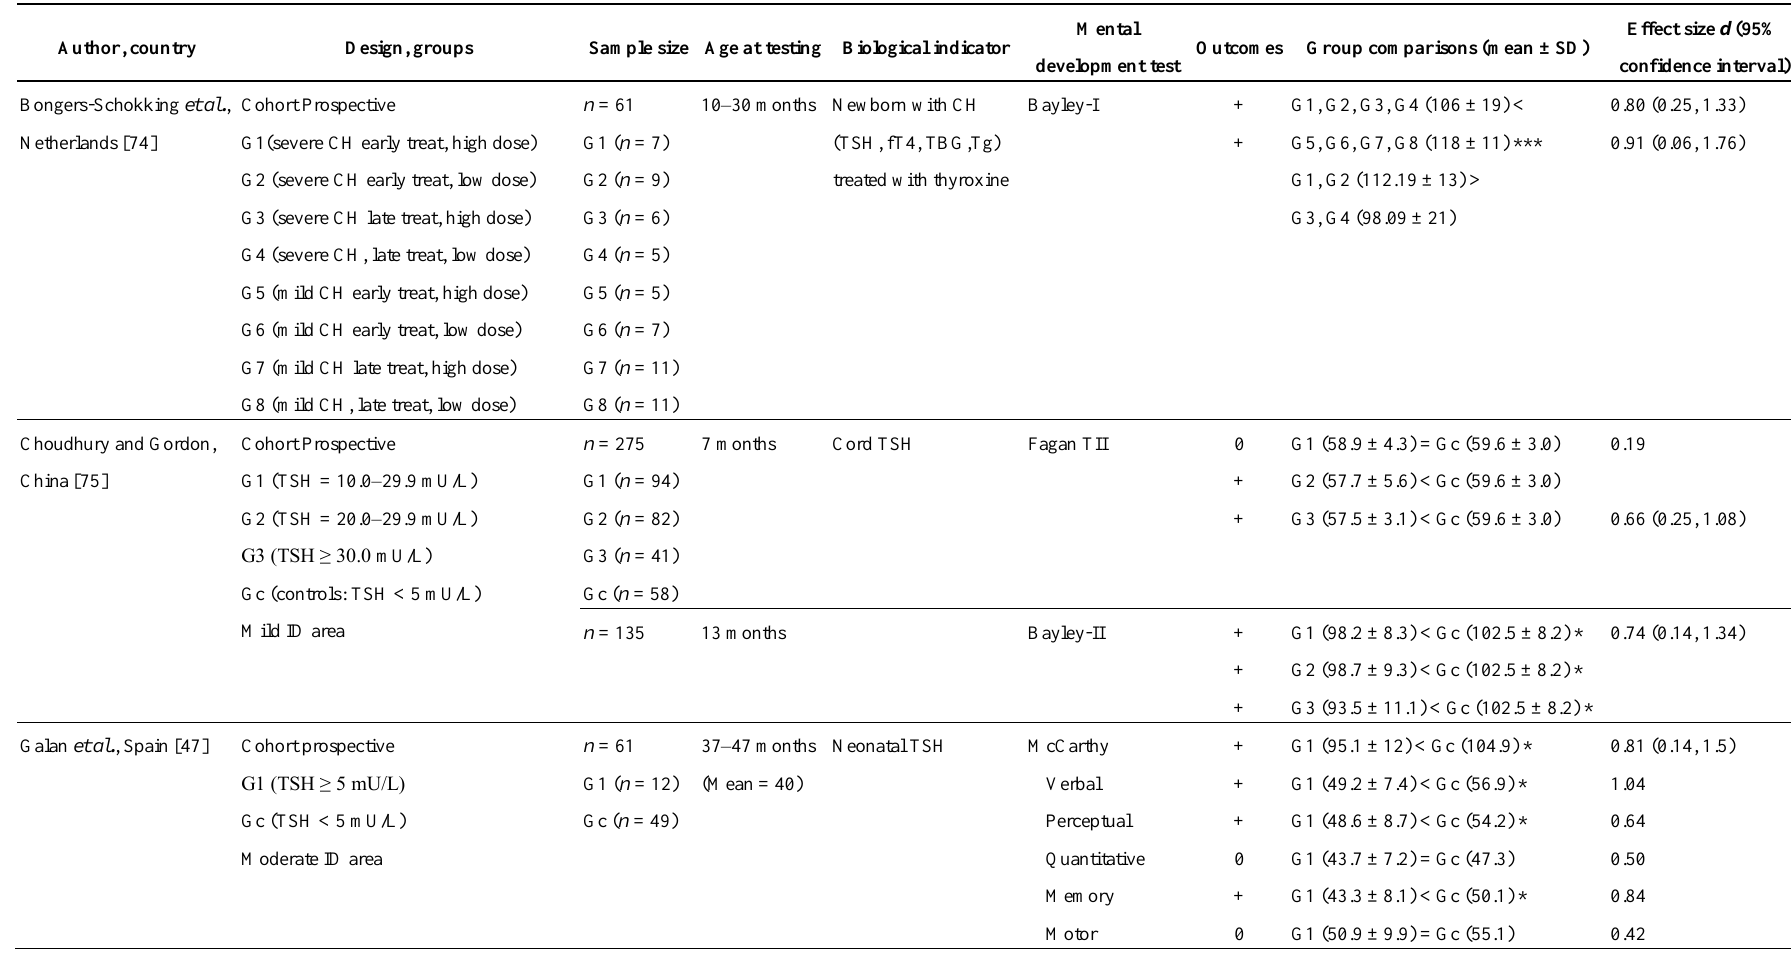
Table 3. Cohort prospective studies stratified by infant iodine